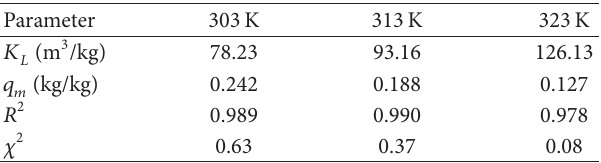
T 2: Langmuir ’s isotherm parameters for the adsorption of MB